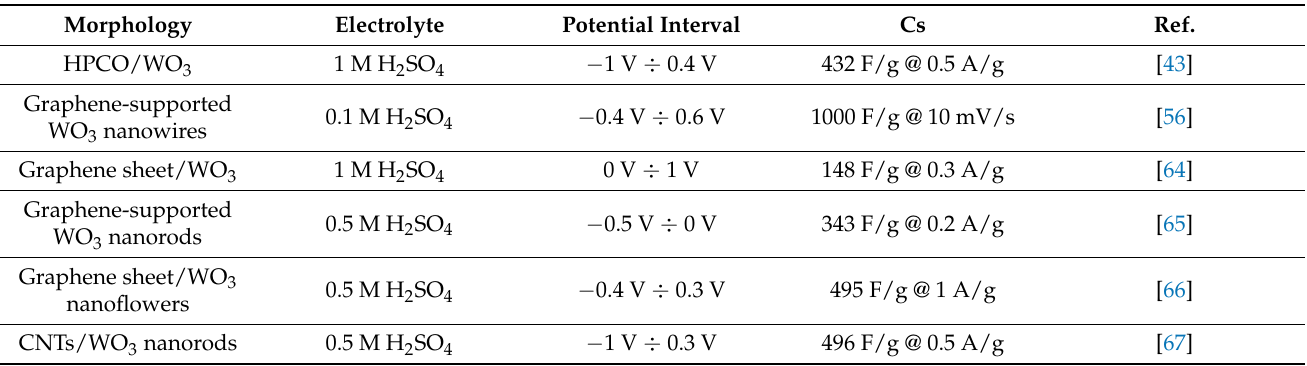
Table 2. Recent, state-of-the-art progress on energy storage applications of WO 3 –carbon nanocomposite- based